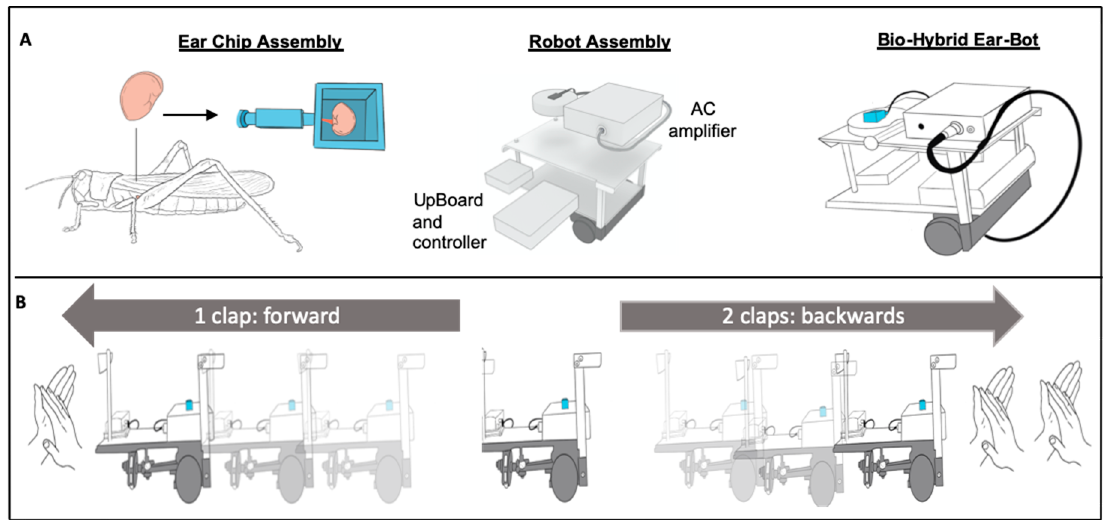
Figure 1. The establishment of the Ear-Bot ( A ) Left to right: The tympanal membrane of the locust ear and its position on the animal’s body; locust auditory organ inside a special chip designed for best electrophysiological recording and later to be attached to the mobile platform; Ear-chip attached to the mobile platform creating the Ear-Bot. ( B ) The Ear-Bot response to sound. Once the Ear-Bot identifies one sound (clap) it goes forward, and once the Ear-Bot identifies two sequential sounds (claps), it moves backwards.